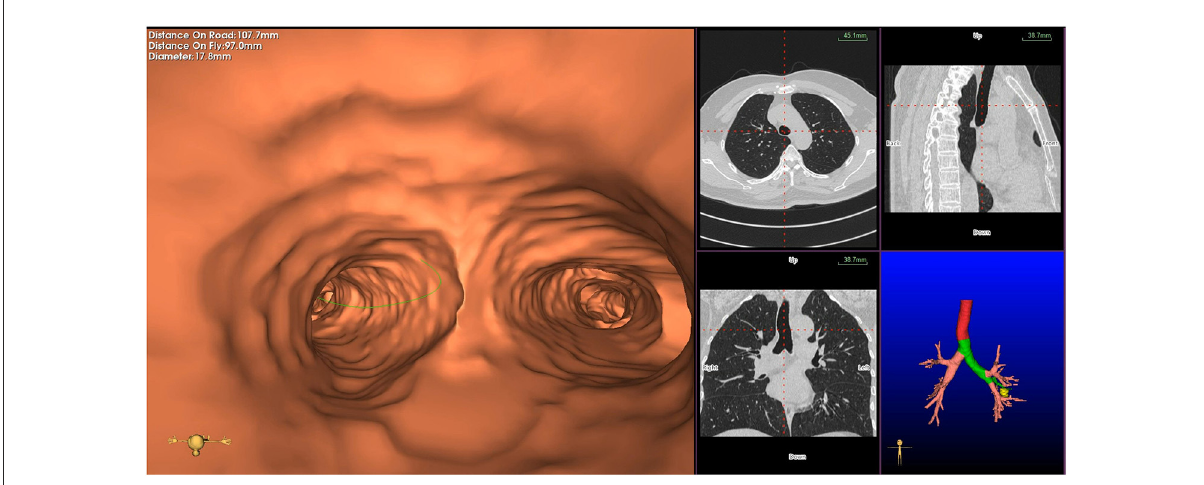
FIGURE1 Virtual bronchial path (fly through) to the target peripheral pulmonary lesion (green line represents bronchial